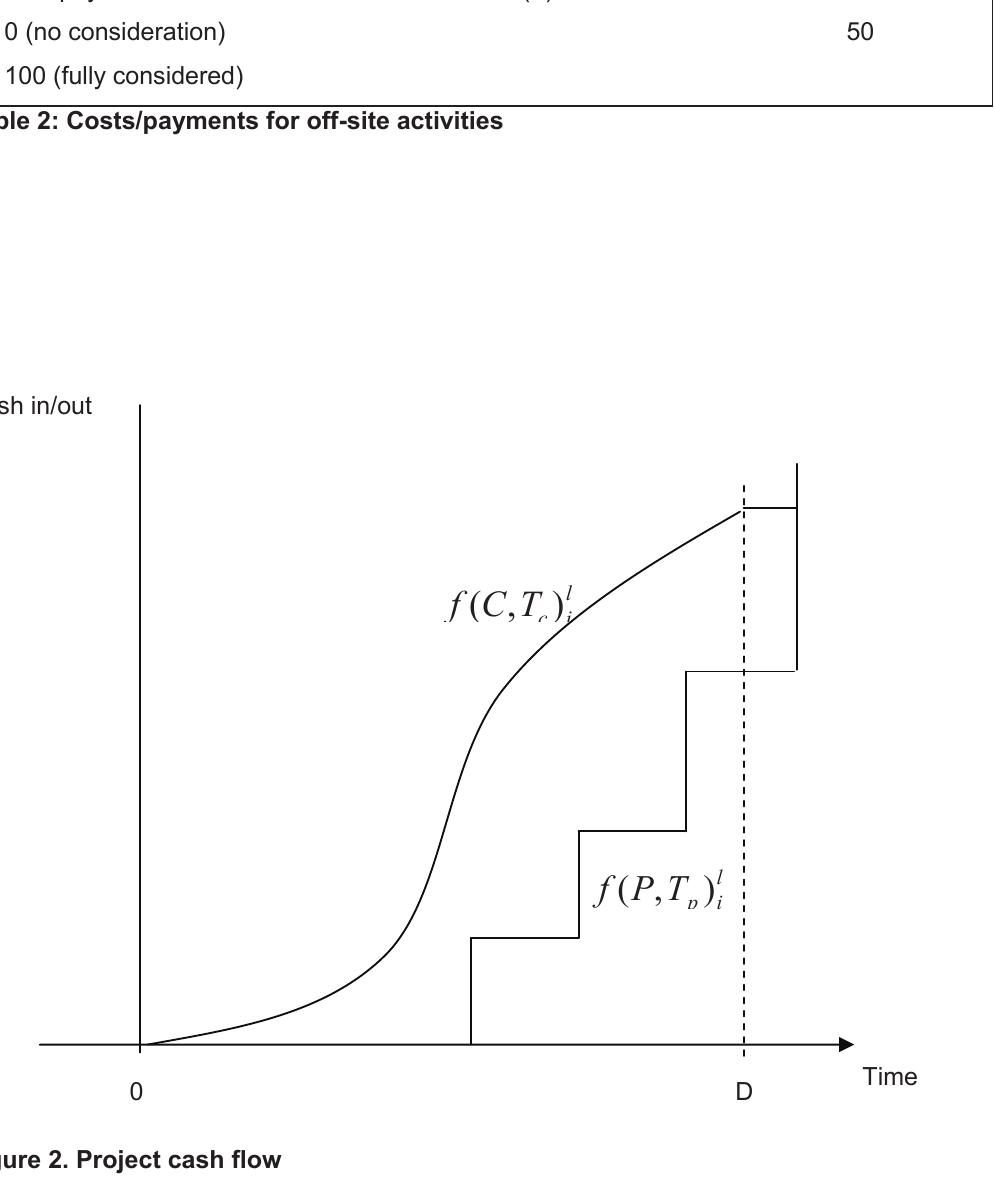
Figure 2. Project cash